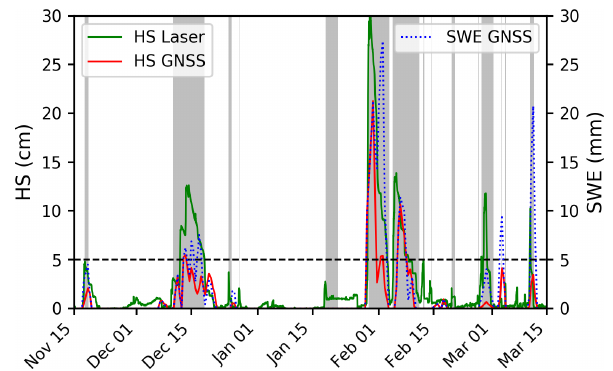
Figure C1. GNSS-derived SWE and HS from laser sensor measure- ments at Küblis for the 2019–2020 winter season. The gray zone indicates when snow was covering the GNSS ground antenna as determined from concurrent webcam pictures. It can be seen that for HS > 5cm and SWE > 5mm (horizontal dashed line) the GNSS system could discern well if snow was laying on the ground well.